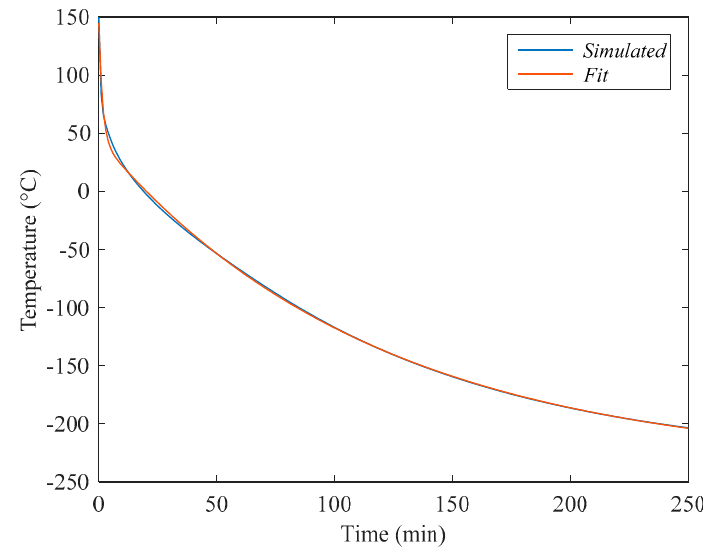
Figure 13. The blue line represents the temperature of the cold finger, and the others represents three sensors placed on the top of the sample holder. It is possible to see that the sample holder can reach a temperature of − 150 °C in 135 min.